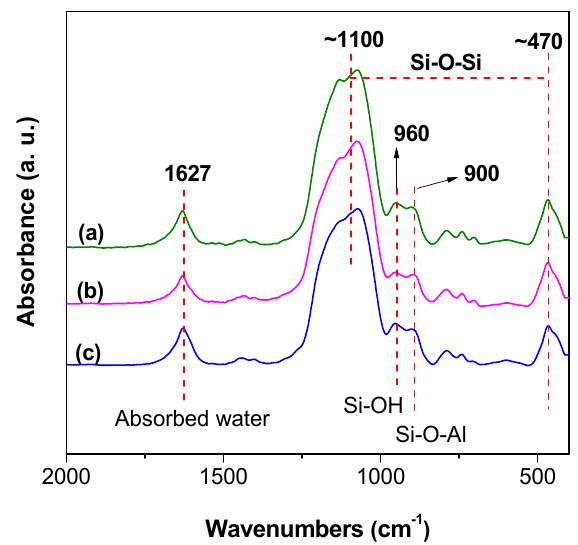
Figure 2. Fourier-transform infrared (FTIR) spectra of ( a ) sample A, ( b ) sample B, and ( c ) sample C.